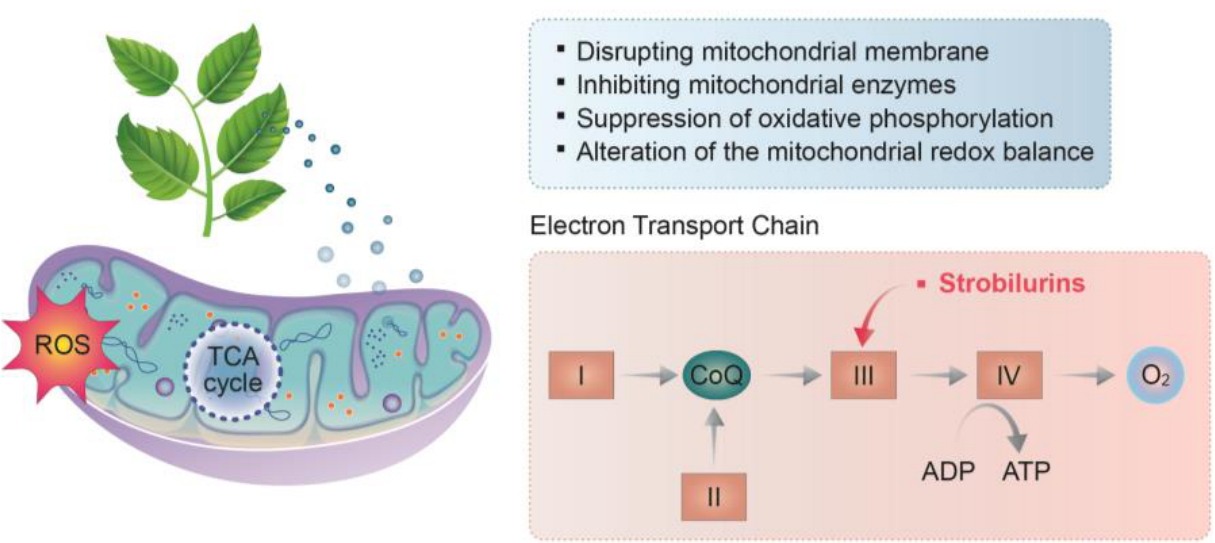
Figure 4. Mechanism of action of plant-derived natural compounds and antifungal agents acting on the mitochondria of A. flavus . I, II, III, IV, mitochondrial complex I, II, III, IV. 4. Antiaflatoxigenic Mechanisms of Plant-Derived Natural Compounds and EOs against A. flavus